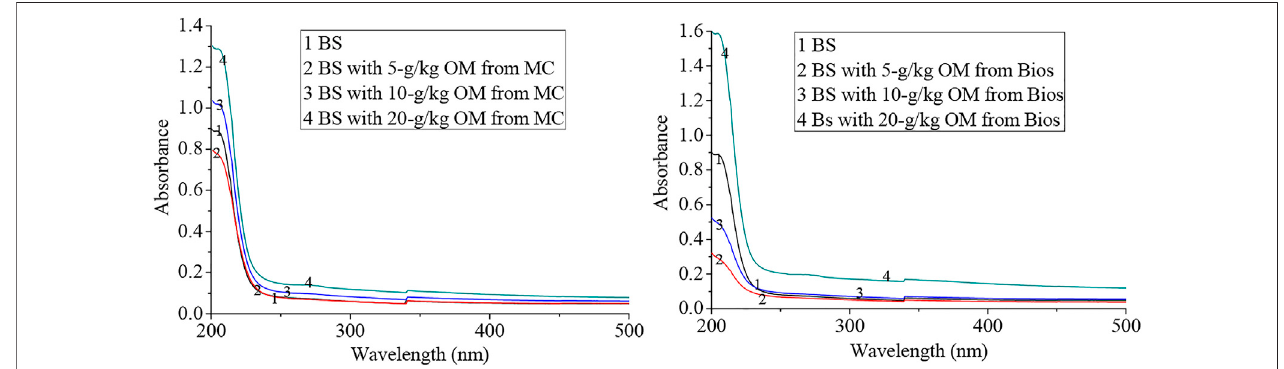
FIGURE 1 | UV spectra of dissolved organic matter extracted from incubated soils (absorbance was standardized to 10 mg C/L).